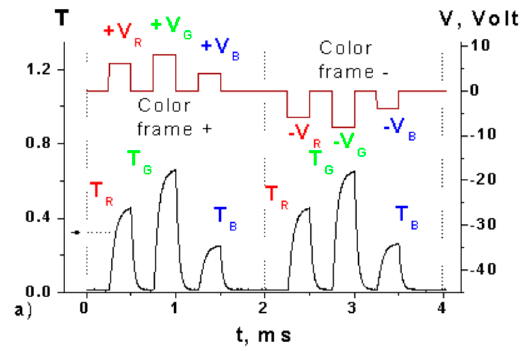
Figure 13. Bottom is the electrooptical response of the DHF. Top is driving signal applied and synchronized sequentially with corresponding red, green, and blue light emitting diodes [38].